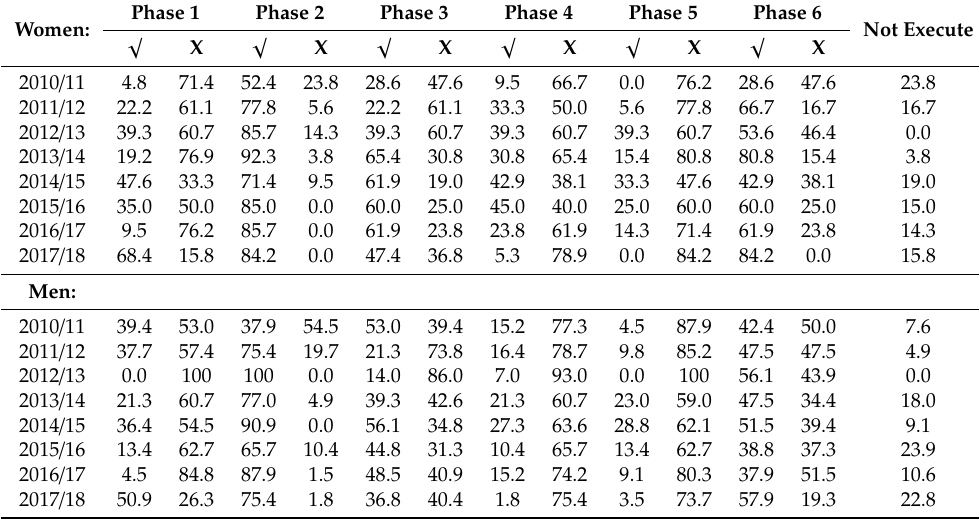
Table 6. Analysis of technical execution of handstand according to movement phases and gender. Women: